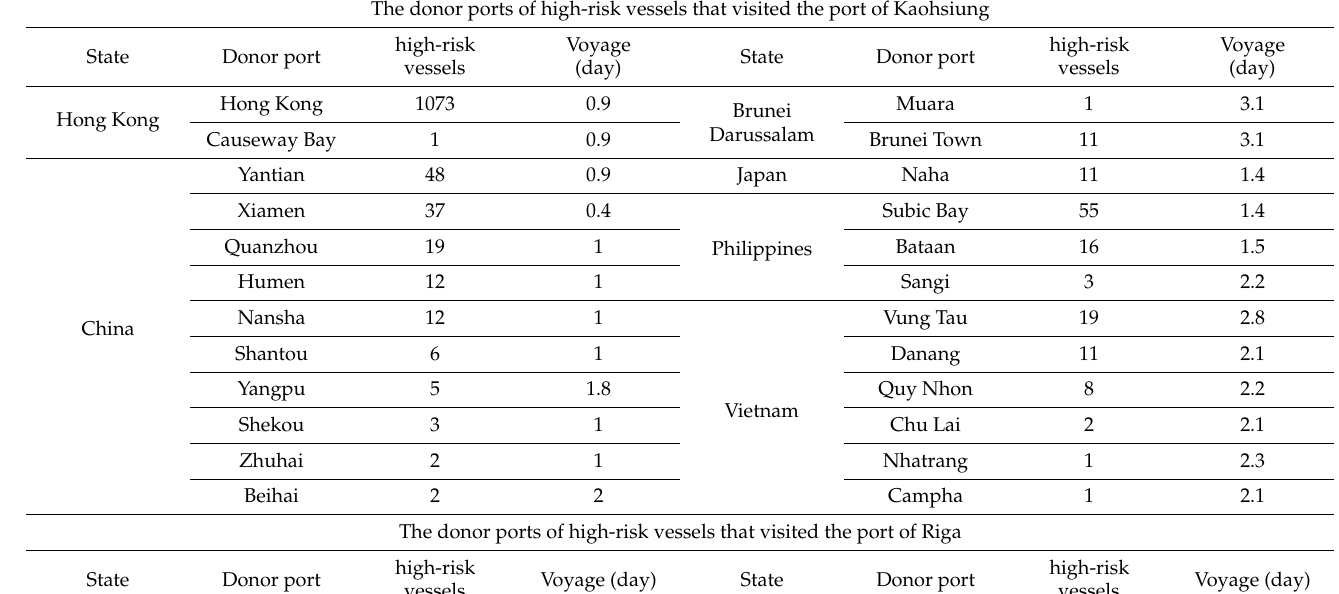
Table 5. The donor ports of high-risk vessels that visited the ports of Kaohsiung and Riga. The donor ports of high-risk vessels that visited the port of